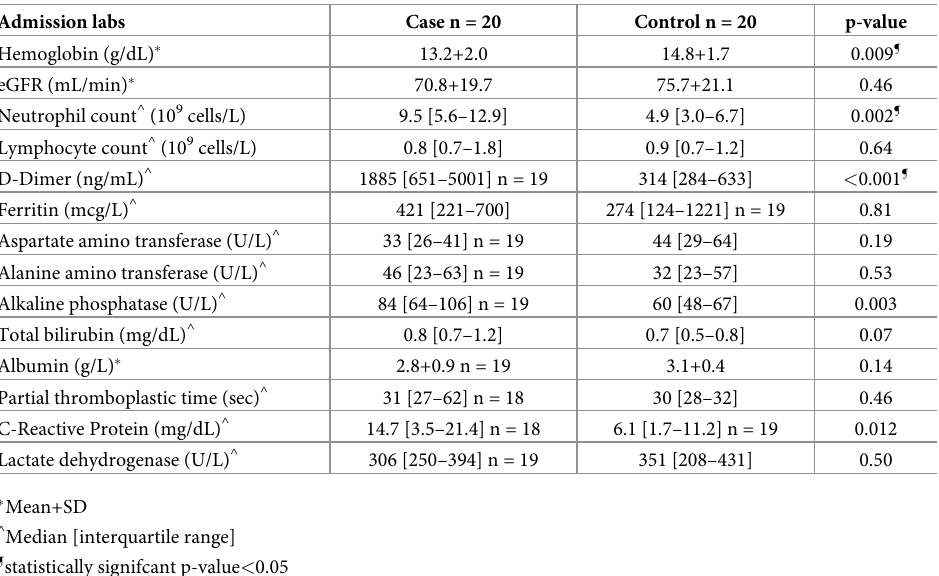
Table 2. Admission Laboratory evaluation